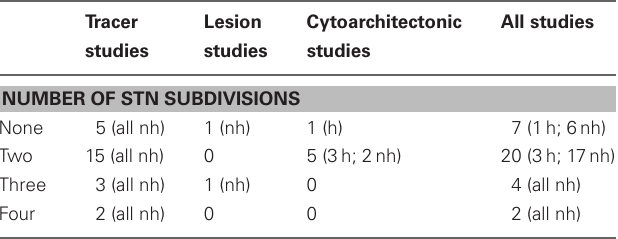
Table 1 | Summary of 33 studies that examined the number of subdivisions in the STN for human and nonhuman